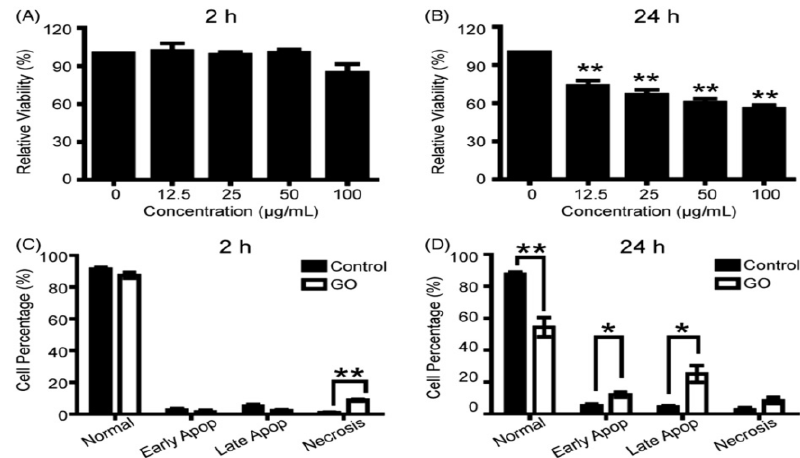
Figure 13. WST-8 assay results for human corneal epithelium cells (hCorECs) exposed to GOs of various doses for ( A ) 2 h and ( B ) 24 h, respectively. Apoptosis flow cytometric analysis of hCorECs exposed to GO (50 µg/mL) for ( C ) 2 h and ( D ) 24 h, respectively. Three independent experiments were performed for both assays. Data were presented as mean ± SEM (standard error of mean). * denotes p < 0.05 and ** represents p < 0.01. Reproduced from [113] with permission of Taylor & Francis.